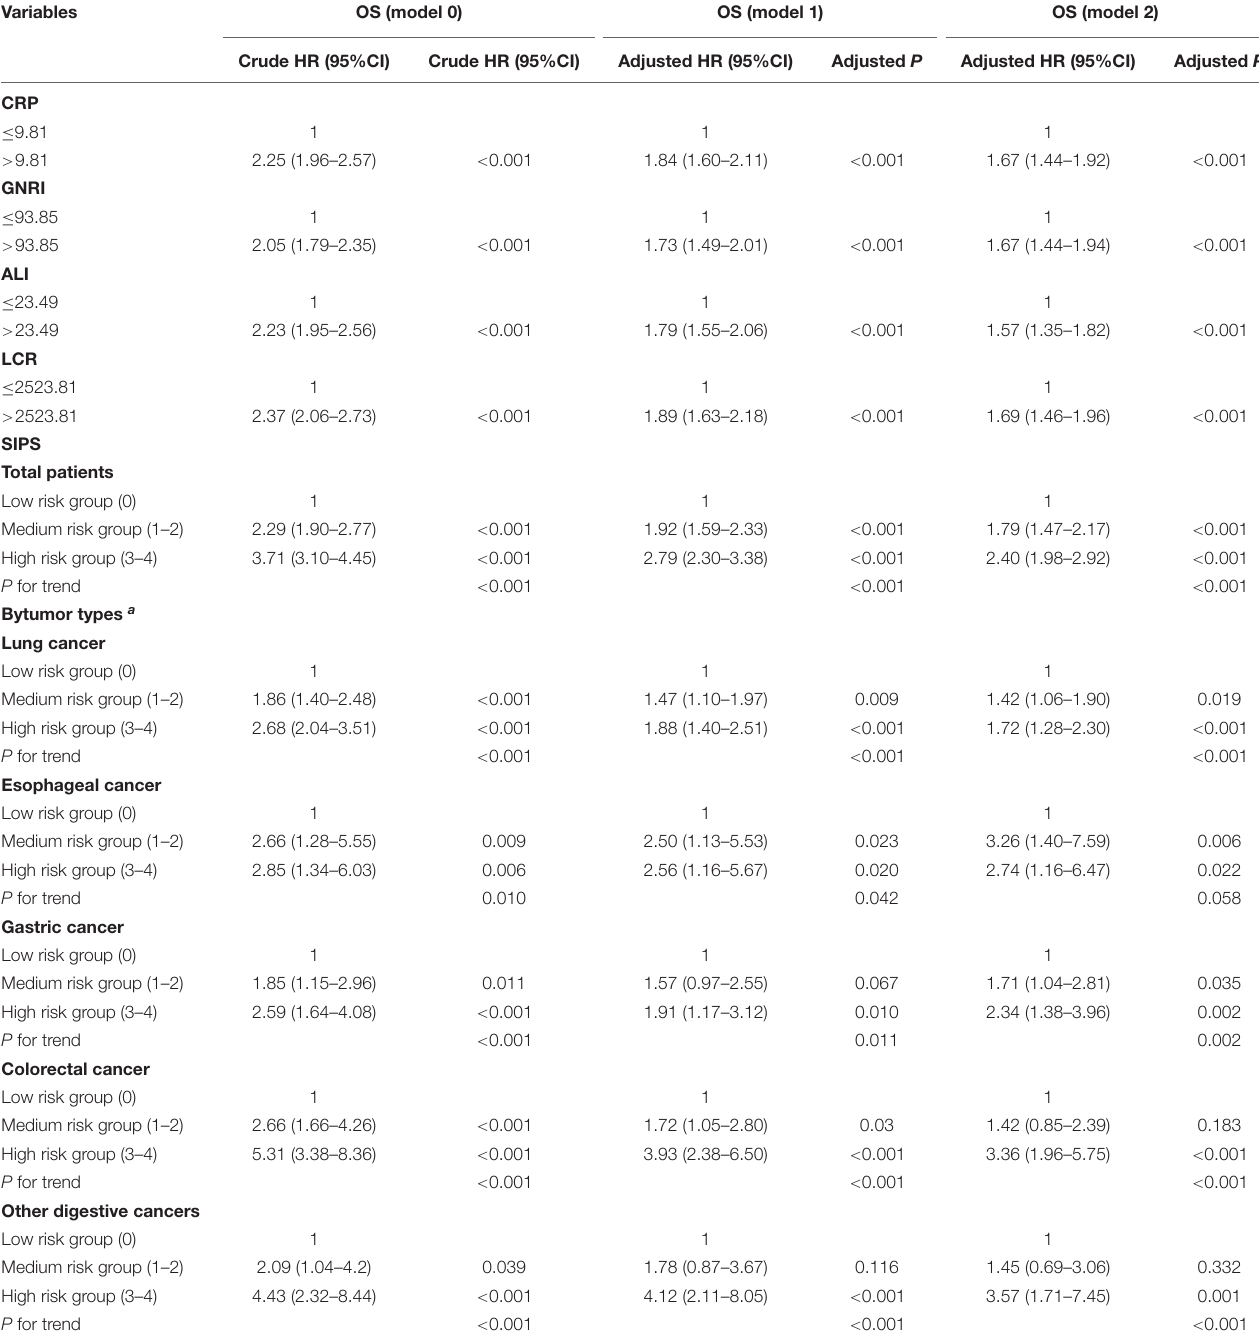
TABLE 2 | The univariate and multivariate analysis of SIPS in total patients and different tumor types.